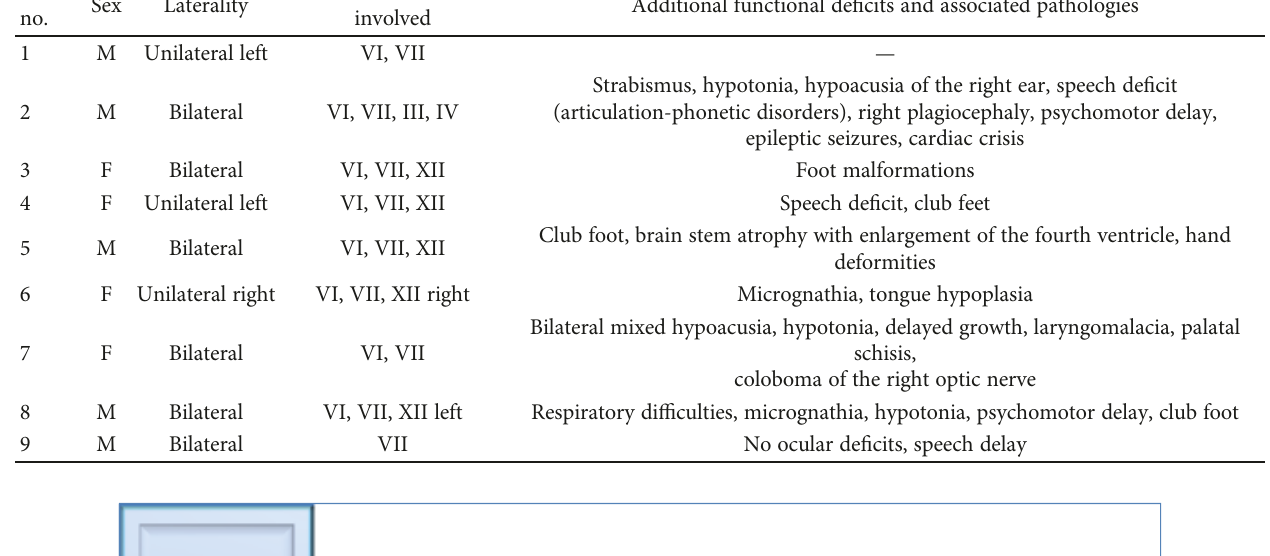
Table 1: Moebius subjects ’ medical cases. The term “ laterality ” refers to the kind of facial paralysis that can be unilateral or bilateral; the sixth and seventh cranial nerves are usually involved, but other nerves may also be a ff ected. “ Associated pathologies ” linked to Moebius syndrome can involve possible hand and foot anomalies, muscle hypotonia, hypoacusis, swallowing and speech problems, and Poland syndrome.